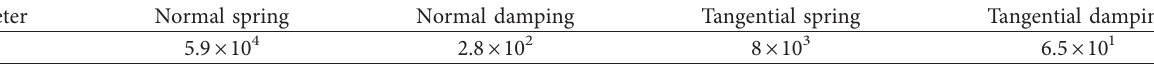
Table 2: Spring-damper unit parameters for the rail and the track slab.